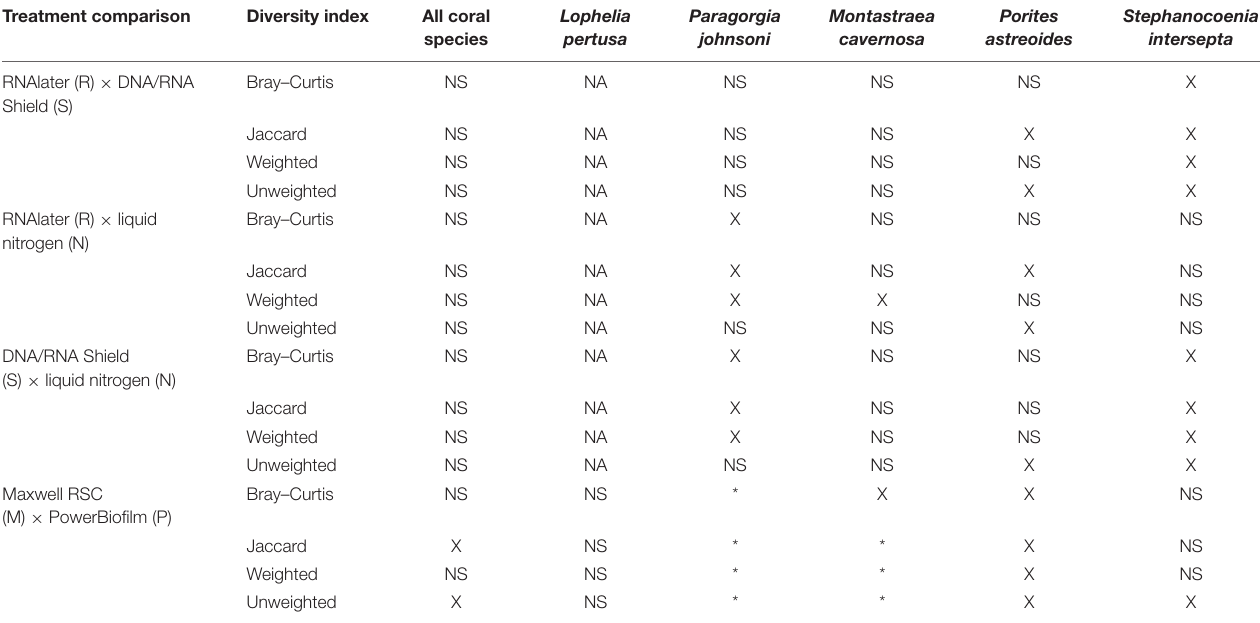
TABLE 5 | Pairwise results for all analysis of similarities (ANOSIM) for all beta diversity metrics, coral species, extraction methods (PowerBiofilm, Maxwell RSC), and preservatives (RNAlater, DNA/RNA Shield, liquid nitrogen). Treatment